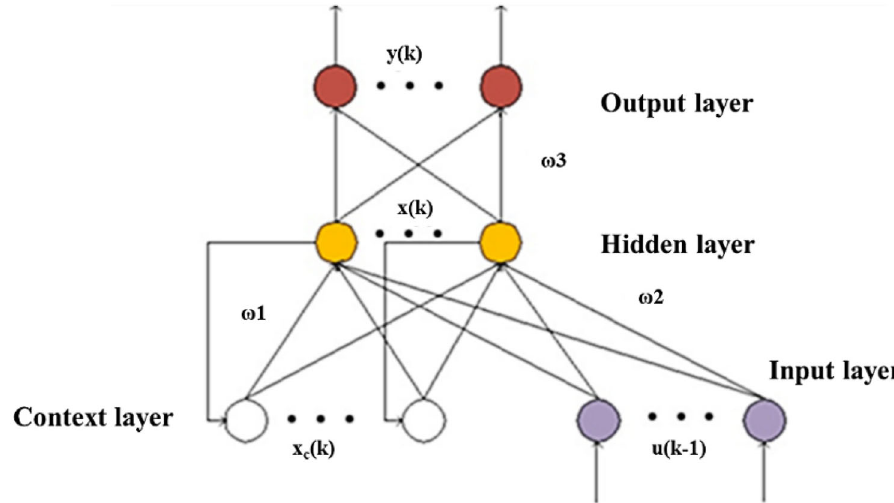
Fig. 1 The Elman